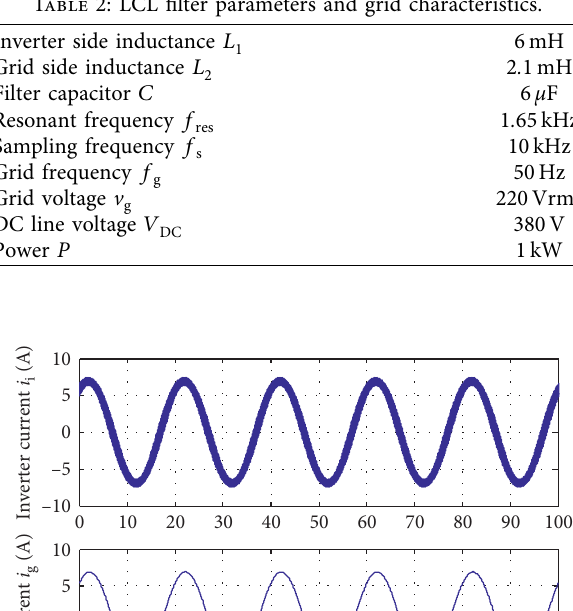
Figure 11: Simulation result when current reference drops to half load conditions from full load conditions.